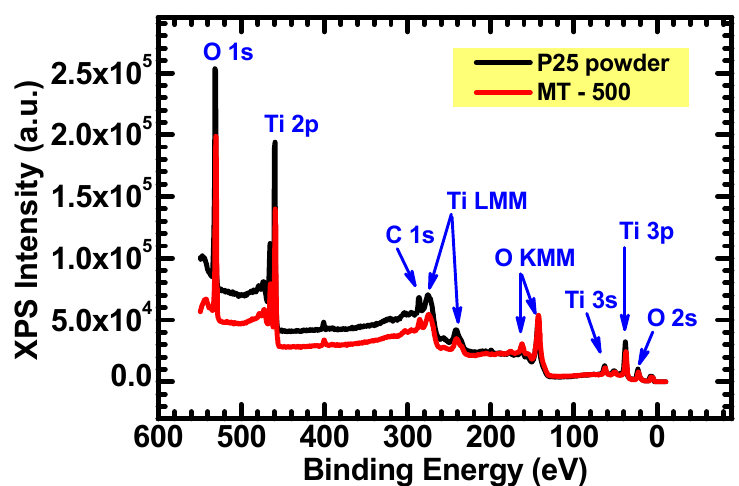
Figure 7. XPS surveys of MT-500 (red line) and P25 (black line).